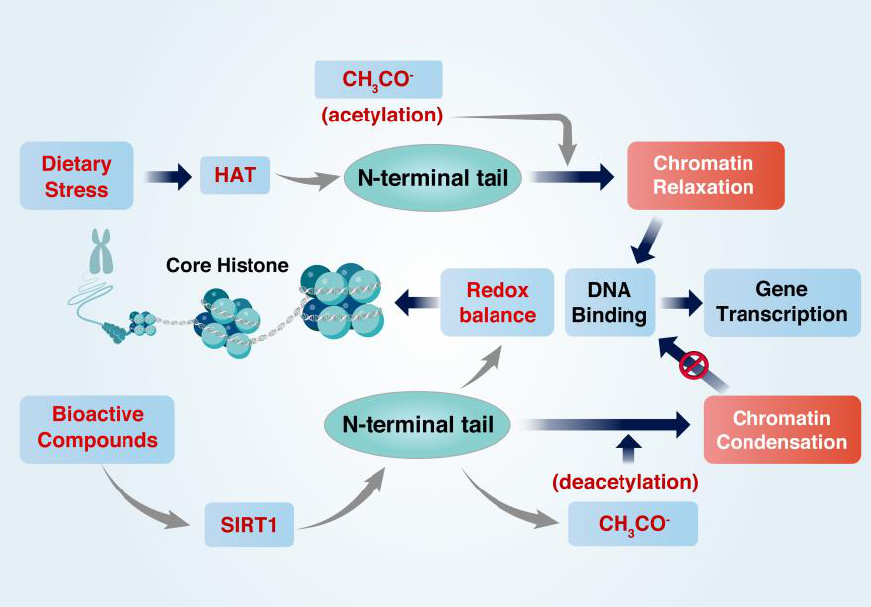
Figure 2. BCs activate SIRT1 for histone deacetylation, whereas dietary stress stimulates HAT for histone acetylation. Histones are the major components of chromatin and assemble with DNA to form nucleosomes. Dietary stress − induced HATs acetylate histone lysine residues, neutralizing the histone positive charge and enabling inflammatory gene transcription. However, BC − activated SIRT1 removes acetyl groups from histones, leading to chromatin condensation and the inhibition of inflammatory gene transcription.